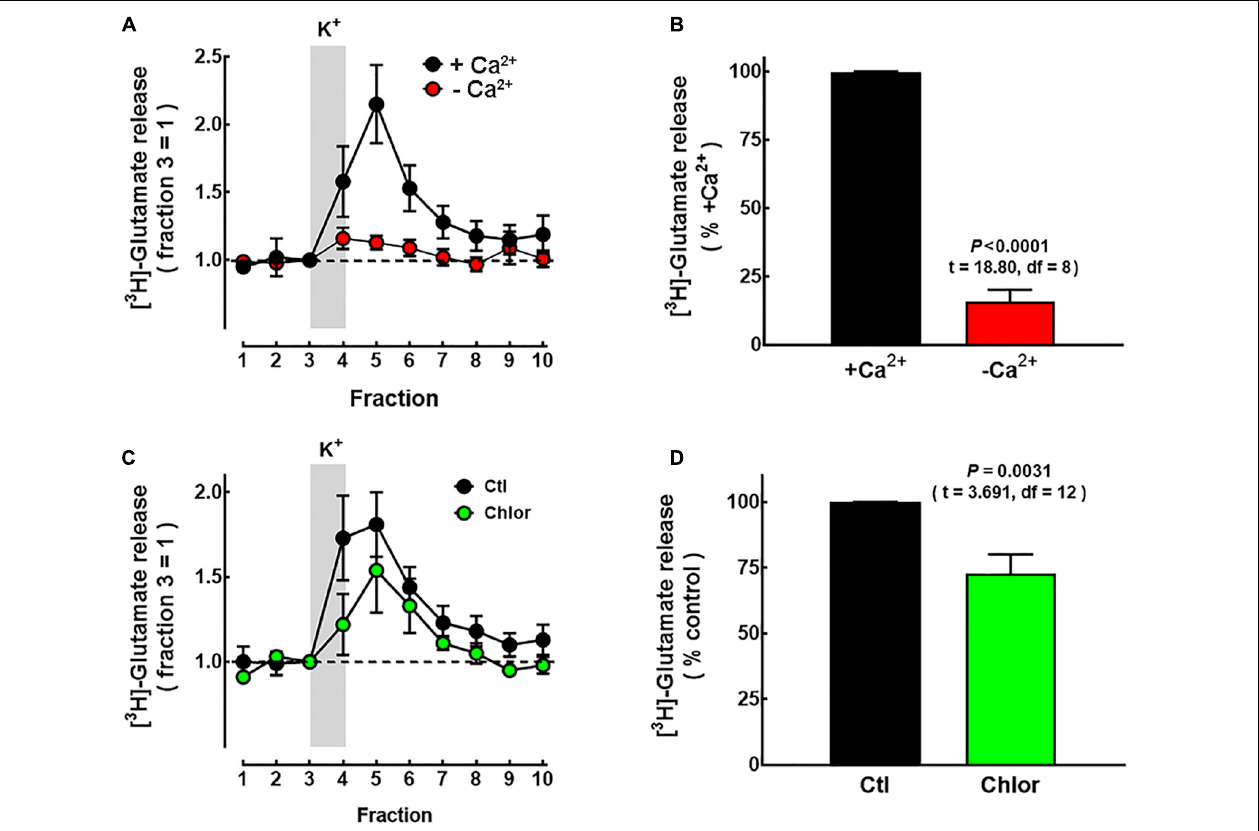
FIGURE 8 | Effect of chlorpheniramine administration to pregnant rats on [ 3 H]-glutamate release in striatal slices from 21-day-old offspring. Slices of P21 animals were obtained as described in Methods and perfused with Krebs–Henseleit (KH) solution. The release of [ 3 H]-glutamate was evoked by raising the concentration of K + in the perfusion solution from 4 to 50 mM for the period indicated by the vertical gray bar. (A) Calcium-dependence of [ 3 H]-glutamate release. Representative experiment of slices perfused with KH solution with no CaCl 2 added (red circles) or containing 1.8 mM CaCl 2 (black circles). Values were normalized to the release in fraction 3 (equals 1) and represent means ± SEM from striatal pools of four P21 animals. (B) Analysis of the area under the curve after subtraction of the basal release. Values are expressed as percentage of the release from slices exposed to Ca 2 + and are means ± SEM from striatal pools of four P21 animals per litter from five different dams per condition. (C) Representative experiment for depolarization-evoked [ 3 H]-glutamate release from striatal slices of P21 offspring from Control (Ctl; black circles) and chlorpheniramine-treated rats (Chlor; green circles). Values are means ± SEM from striatal pools of four P21 animals per group. (D) Analysis of the area under the curve after subtraction of basal release. Values are expressed as percentage of the release from slices of control animals in the same experiment and are means ± SEM from striatal pools of four P21 animals per litter from seven different dams per condition. The statistical analysis was performed with unpaired Student’s t